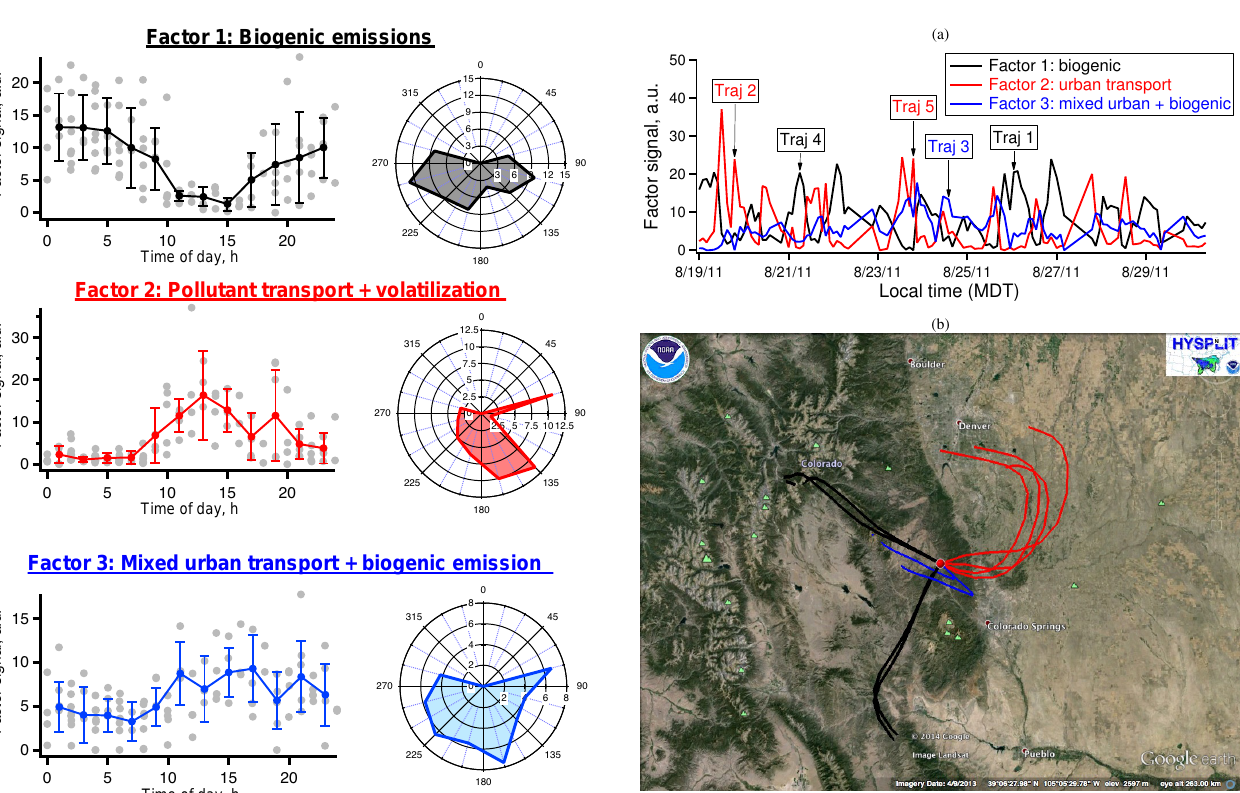
Figure 7. PMF factor wind and diurnal profiles. For each factor, the grey markers represent factor signals for the entire sampling period (grouped by hour of day); the dark line and markers represent diel averages, and the error bars represent one standard deviation. The wind profiles are average factor signals grouped by average wind di- rections. Factor 1 is strongest during the night and during transport from forests to the west and south of the field site, consistent with local biogenic emissions. Factor 2 appears to be strongest during the day, and likely originates from a temperature-dependent volatiliza- tion process (see Fig. S12). It may also represent compounds trans- ported from developed areas to the east. Factor 3 appears to be have mixed sources.